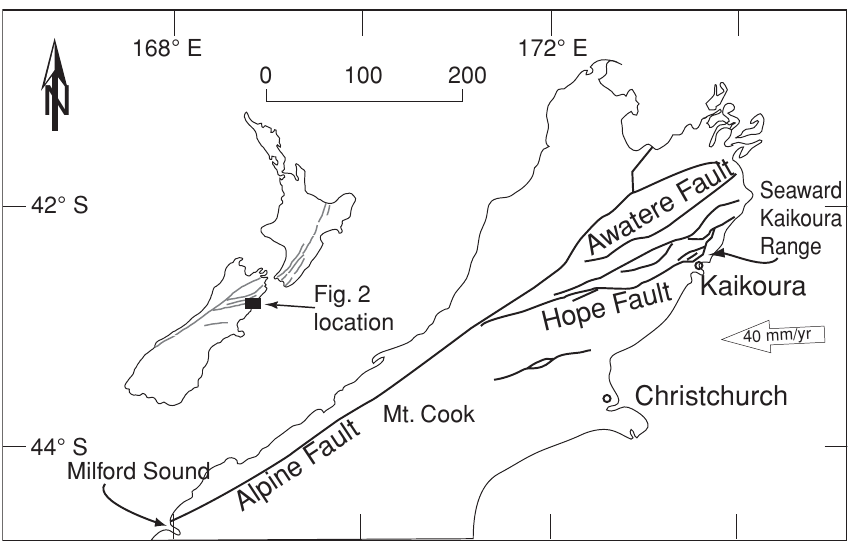
Fig. 1. Tectonic setting of landslide study area in the South Island of New Zealand. Diagonal zone of faulting is along the transpressional boundary between the Pacific and Australian plates. Plate convergence rate inside the arrow is from De Mets et al. (1994). Location of fig. 2 image is shown by the rectangle on the inset map showing the North Island and South